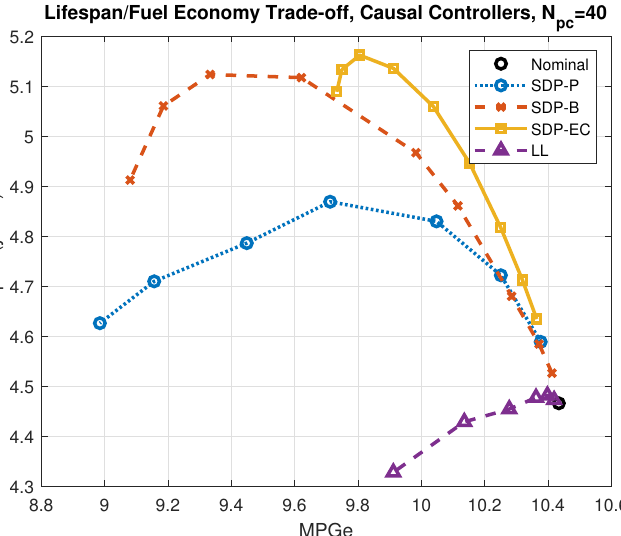
Figure 8. Comparison of energy consumption and battery aging for the four causal control methods, N pc =